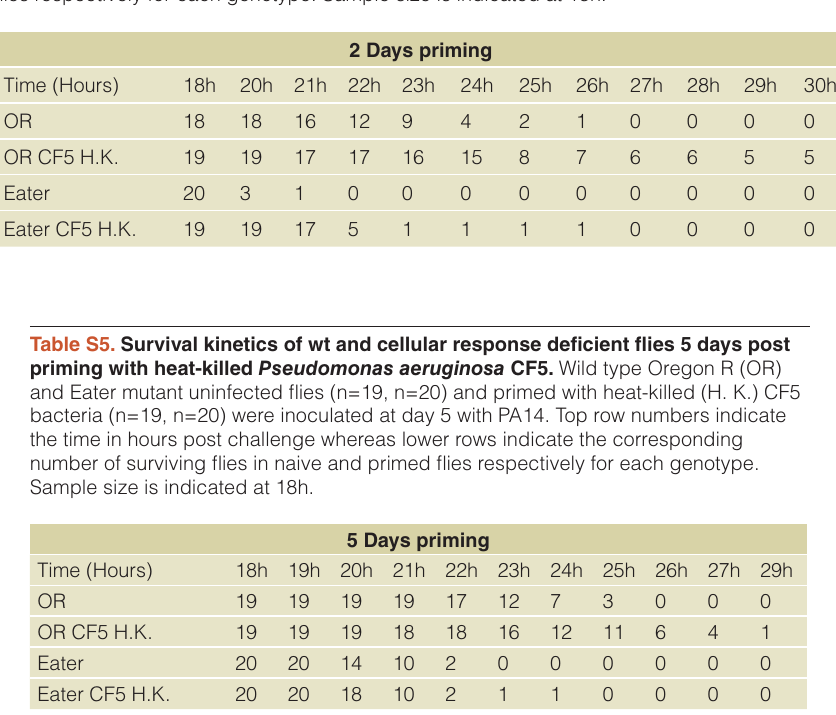
OR OR CF5 H.K. Eater 0 Eater CF5 H.K.